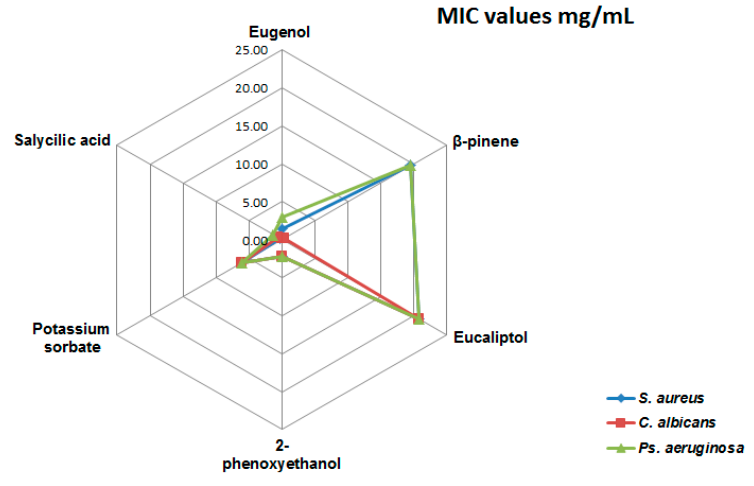
Figure 1. Minimal inhibitory concentration (MIC) values for the tested compounds (mg/mL).